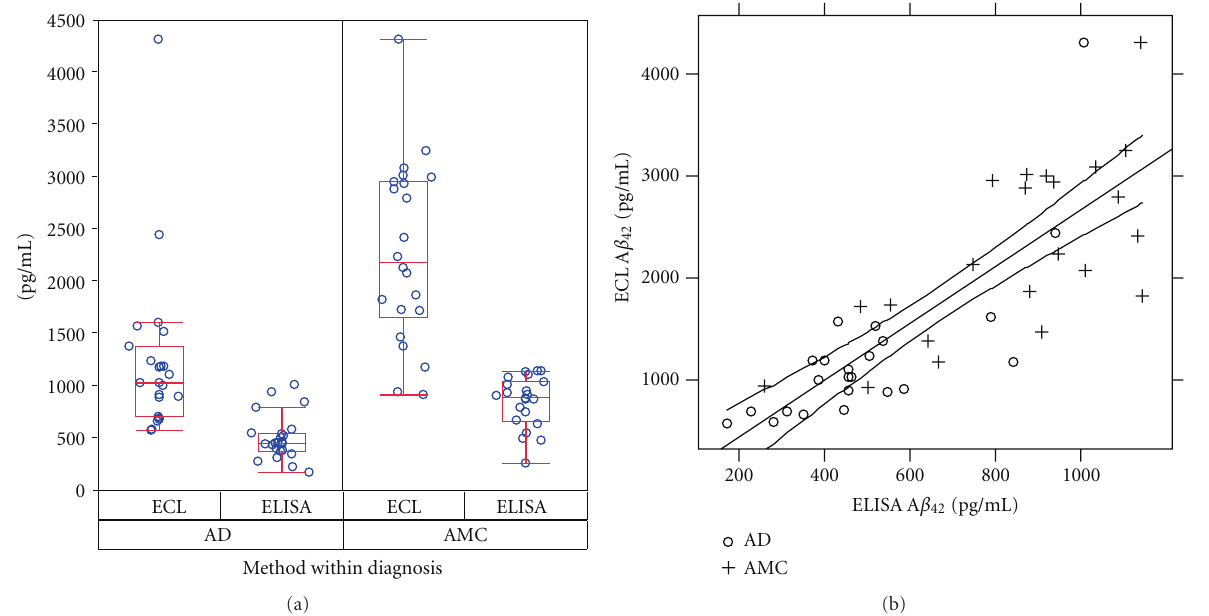
Figure 1: (a) CSF A β 42 levels measured in both ELISA and ECL assay. Box plots of CSF A β 42 levels from ELISA and ECL separated by diagnosis (AD and AMC) and method of detection. Boxes represent the interquartile ranges: bottom of box, black dot, and top of box indicate the 25, 50, and 75th percentile of the data. The whiskers (dashed bars) extend to the most extreme data points, which are no more than 1.5 times the height of the box away from the top or bottom of the box. (b) Correlation between ELISA and ECL. Correlation coe ffi cients r = 0 .